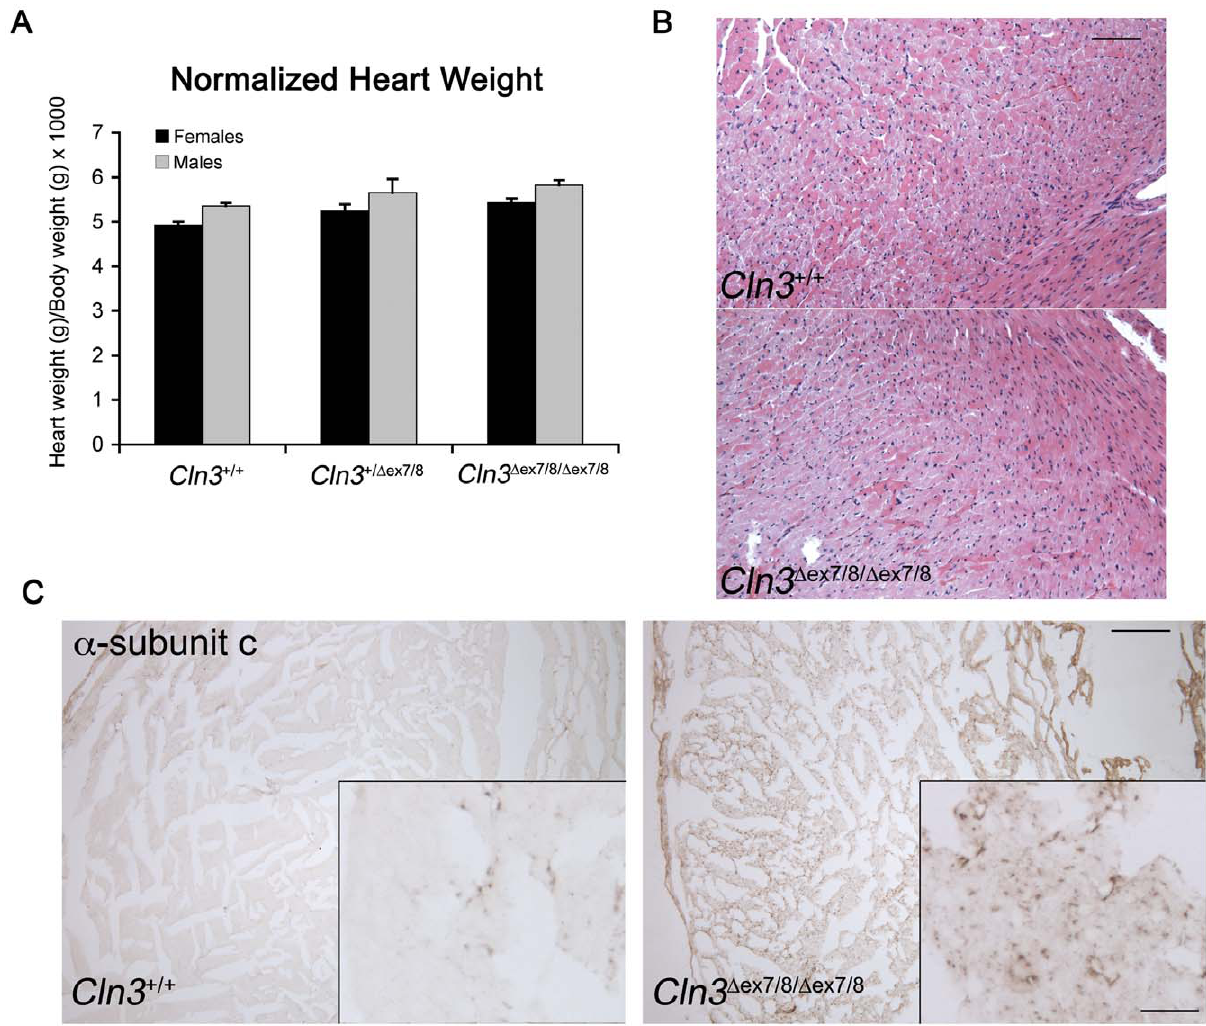
Figure 4. Heart analysis of Cln3 D ex7/8 mice. (A) The bar graph depicts normalized heart weights for wild-type ( Cln3 + / + ), heterozygous ( Cln3 + / D ex7/8 ), and homozygous ( Cln3 D ex7/8/ D ex7/8 ) littermate 19–20 week old mice. Normalized heart weights represent a ratio of heart weight (mg=milligrams)/ body weight (g=grams). Normalized heart weights were slightly increased in heterozygous Cln3 D ex7/8 mice, and more so in homozygous Cln3 D ex7/8 mice, compared to wild-type littermates. ANOVA analysis suggested a significant genotype effect (p , 0.05). (B) Representative micrographs of hematoxylin and eosin (H&E) stained heart sections from wild-type ( Cln3 + / + , n=8) and homozygous ( Cln3 D ex7/8/ D ex7/8 , n=10) littermate 19–20 week old mice are shown, which do not obviously differ from one another in their morphology. Scale bar=100 m m. (C) Representative micrographs are shown of a -subunit c immunostained heart sections from 19-week old Cln3 + / + and Cln3 D ex7/8/ D ex7/8 littermate mice. Note the abundance of subunit c- immunopositive deposits in the Cln3 ?ex7/8/ D ex7/8 section. Only sparse punctate subunit c immunostaining is present in the Cln3 + / + section. Scale bar=200 m m. Inset scale bar=25 m m.